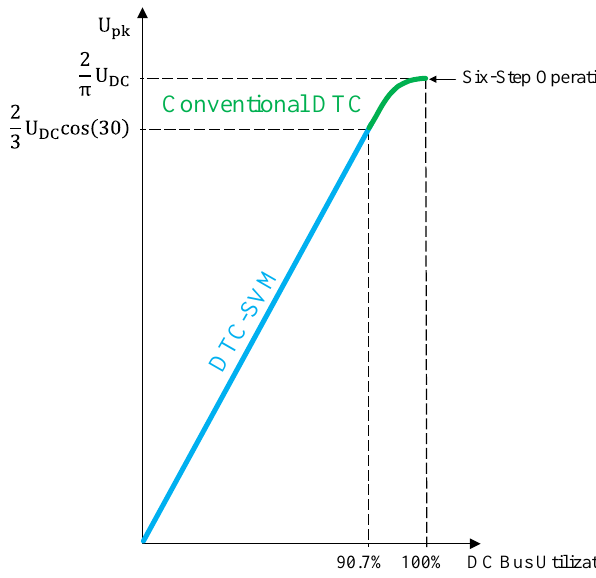
Figure 11. DTC – SVM and conventional DTC working regions. Figure 11. DTC–SVM and conventional DTC working